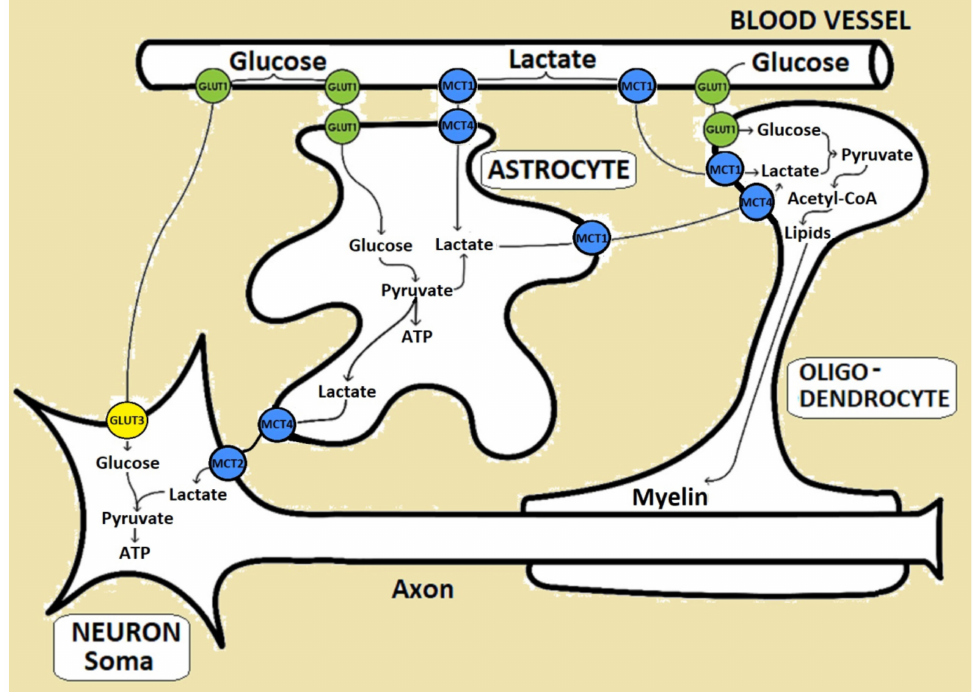
Figure 3. Representation of glucose and lactate fluxes through the BBB. Glucose transporters: Glut1 (depicted in green) is expressed in endothelial cells (part of BBB) and in glial cell membrane; Glut3 (yellow) is expressed in neuron membrane. MCT (monocarboxylate transporters family) is depicted in blue: different isoforms (MCT1, MCT2, MCT4) are expressed in endothelial cells (part of the BBB), neurons, astrocytes, and